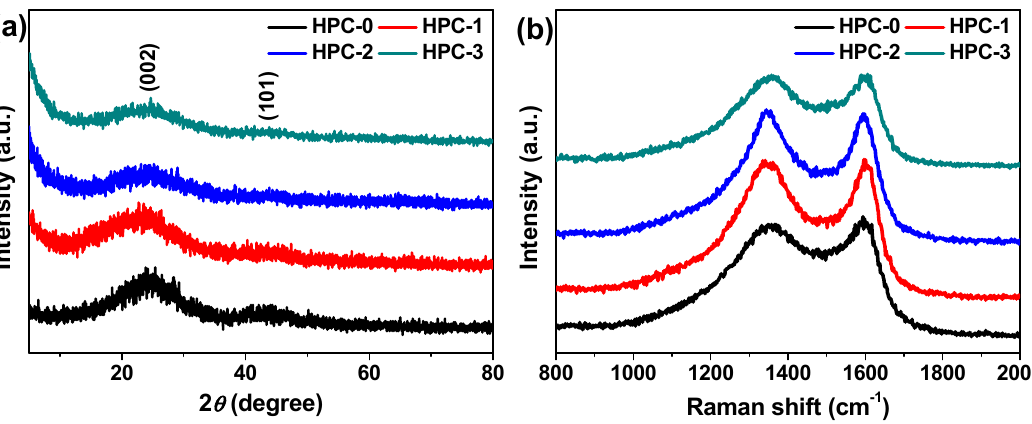
Figure 4. ( a ) Powder XRD patterns and ( b ) Raman spectra of HPC-0, HPC-1, HPC-2, and HPC-3.